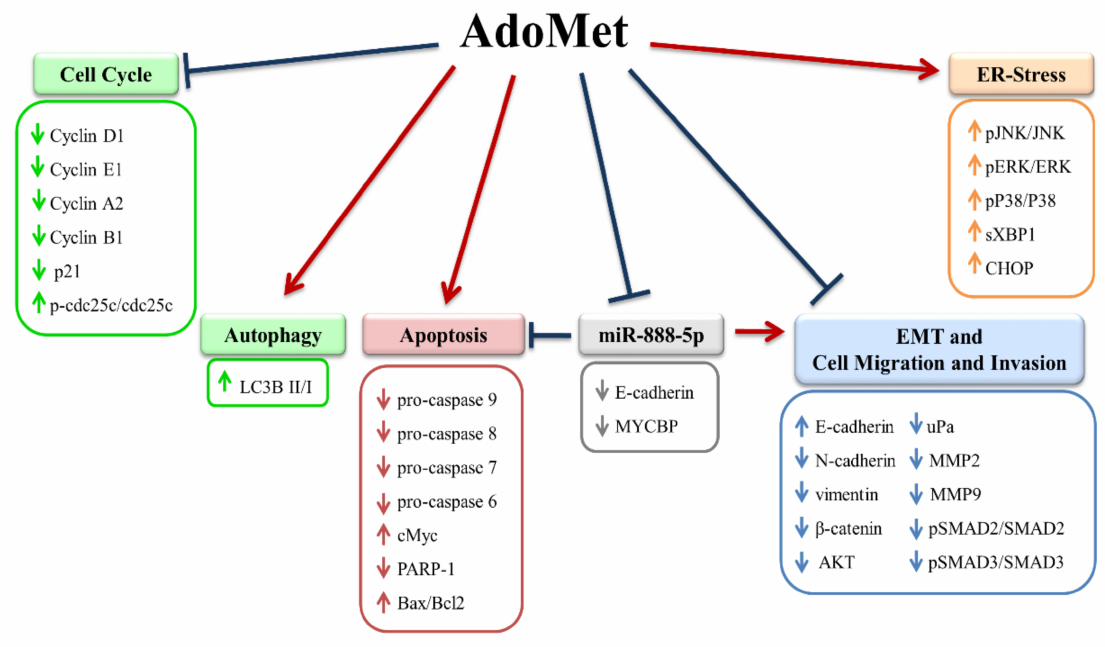
Figure 4. Schematic representation summarizing the multitargeted anticancer effects of AdoMet in